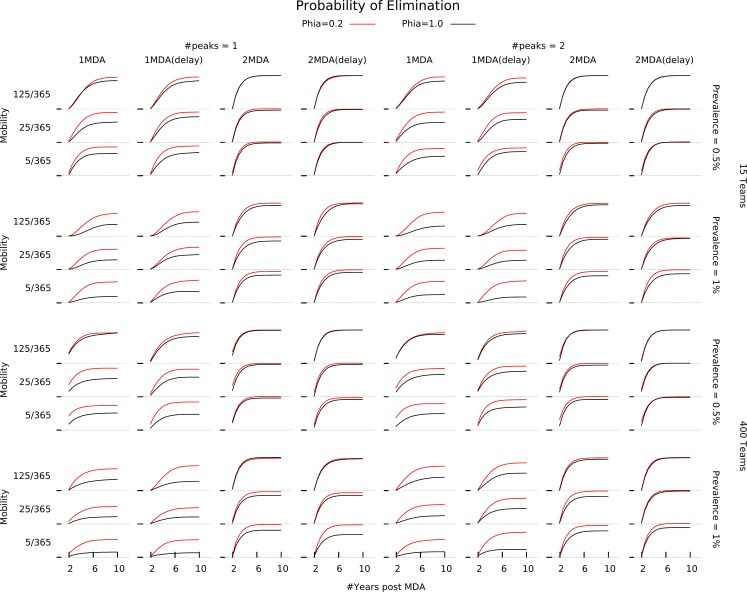
Relationship between elimination probability and the relative infectivity of asymptomatic infections.Illustrates how a lower infectiousness assumption for asymptomatic malaria (red line) drives the likelihood of malaria elimination up for independently of the remaining model parameters.